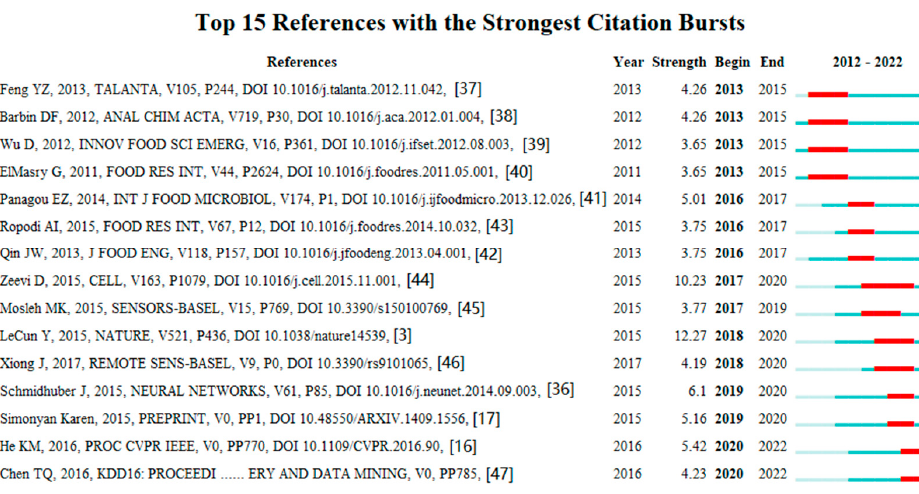
Figure 7. Starting point literature in related subfields.